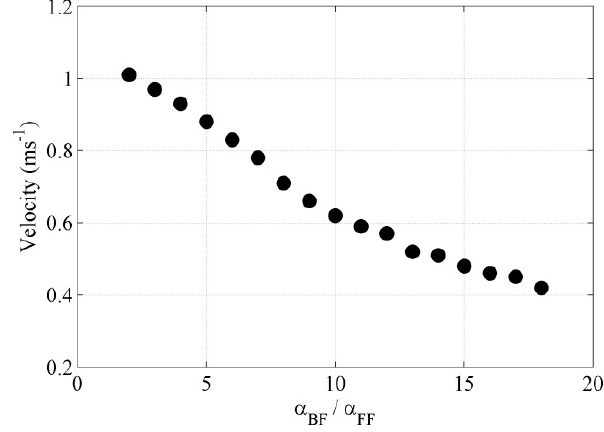
Figure 2. Flow velocity and ViscoBoundFactor (VBF) [8].